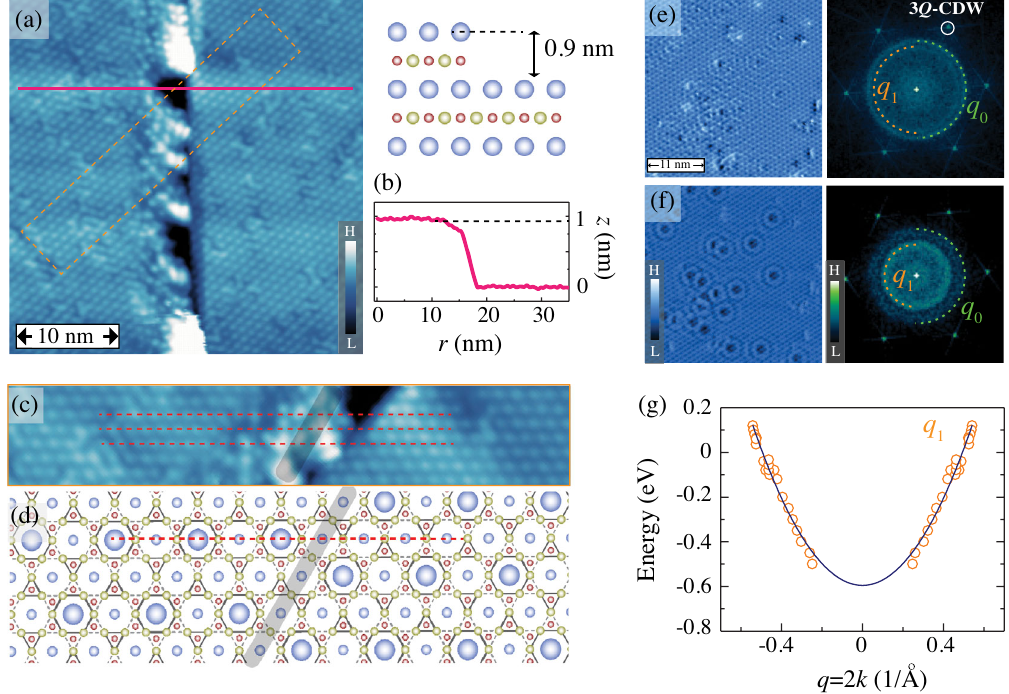
FIG. 2. (a) Topographic image of the half-Cs surface showing a single-unit-cell step. (b) Height profile obtained along the pink line shown in (a). (c) Close-up of the step edge. The dashed pink lines track the chains with CDW modulation on the upper side. A π -phase jump can be observed between the upper and lower sides. (d) Illustration of the CDW patterns near a single-unit-cell step. (e),(f) Normalized dI=dV maps ( dI=dV ð r ; eV Þ = ½ I ð r ; eV Þ =V (cid:4) ) and their FTs at − 80 and − 300 mV, respectively. The white circle denotes one of the 3 Q -CDW wave vectors. The clearly dispersing vector is marked as q 1 . (g) The energy dispersion of q 1 extracted from line cuts of the FTs and a parabolic fit, E ¼ 9 . 77 k 2 − 0 . 6 . STM setup condition: (a) V S ¼ − 100 mV, I t ¼ 80 pA, (e) V S ¼ − 80 mV, (f) V ¼ − 300 mV, I ¼ 450 pA, V ¼ 4 S t m